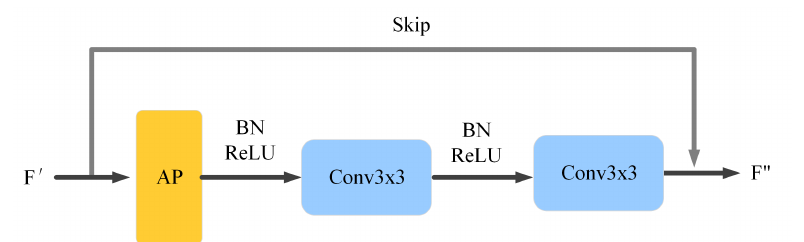
Figure 4. Downsampling